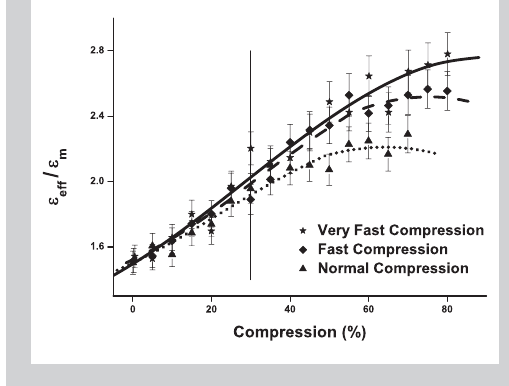
Figure 5: Top and side views of the particle monolayer, just before the compression (left) and after compression by 45 % of the initial size (right). Figure 6: Computed effective dielec- tric constant of the nano- particle monolayer, with reversible bonds, at differ- ent stages of compression for different compression rates: 10 -4 ( ¯ , ——), 5·10 -5 ( Ï , ----) and 10 -5 ( Ú , • • • •) in inverse simulation time unit. The black lines repre- sent the best polynomial fit- ting of order 3, for each sim-